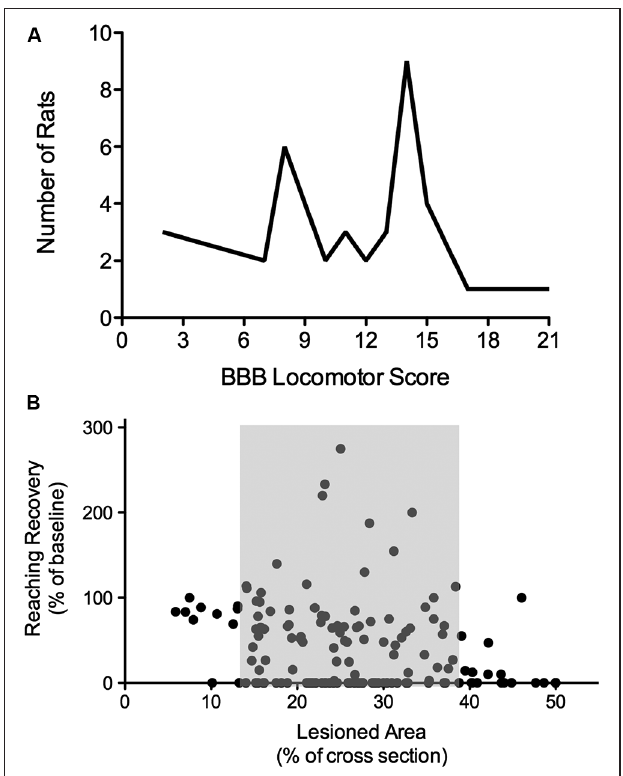
FIGURE 1 | Nonlinearity of lesion severity and functional recovery. (A) Clustering of animals in the BBB locomotor score. Although T8 lesion severity and location (dorsal versus ventral) were applied randomly, two scoring points were assigned most frequently, indicating thresholds in the BBB scale. Adapted from Schucht et al. (2002). (B) Correlations of lesion and reaching success. Total lesioned area at C4 was not correlated with final single pellet reaching success. Success is consistently high with small lesions and low with extensive lesions, however, when approximately 14–38% of the dorsolateral spinal cross section is lesioned, there is substantial variability in reaching recovery (grey area). Adapted from Hurd et al.